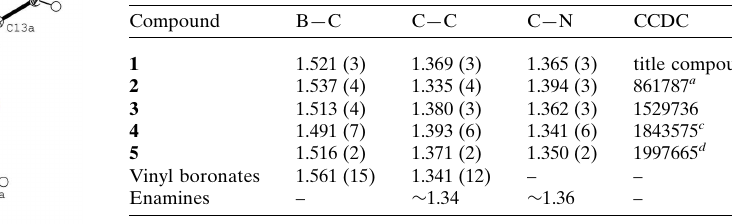
Table 1 Comparison of bond lengths (in A˚ ) in 1 with those in the similar compounds 2 – 5